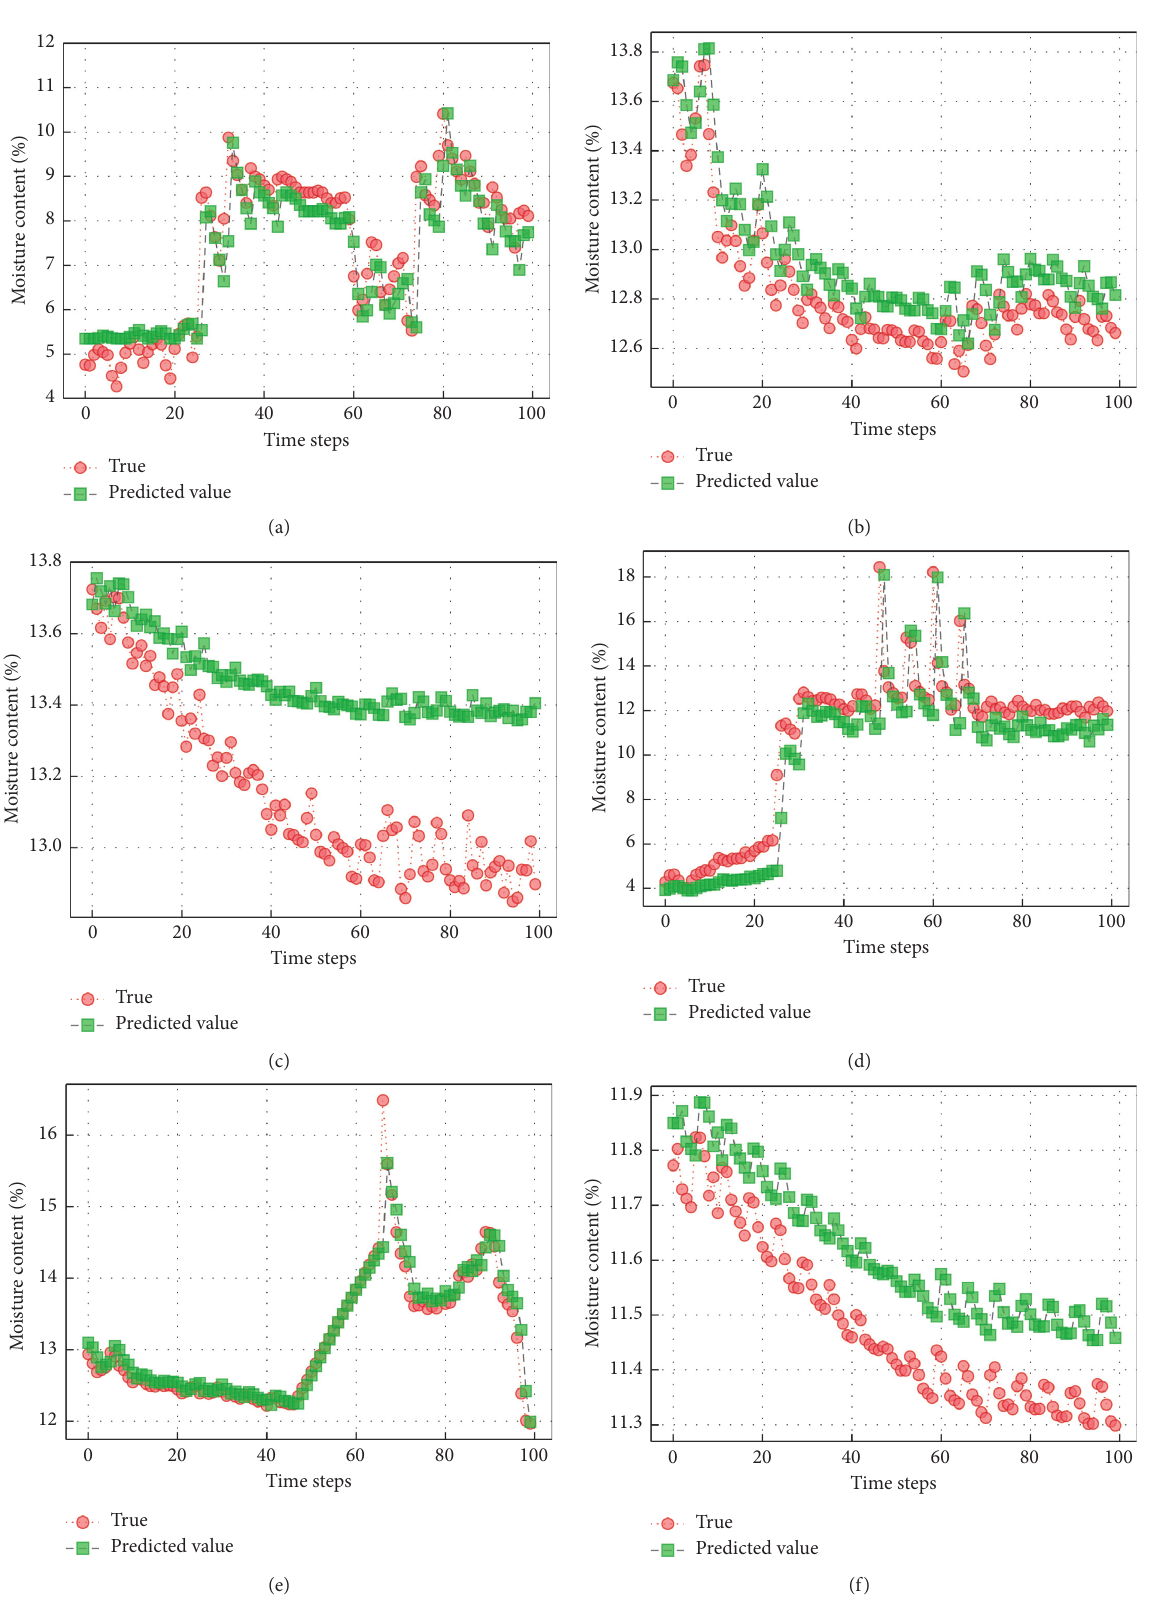
Figure 5: Predicting results of two subgrade sections in the three depths. (a–c) K 2020+024 section. (d–f) K 2028+746